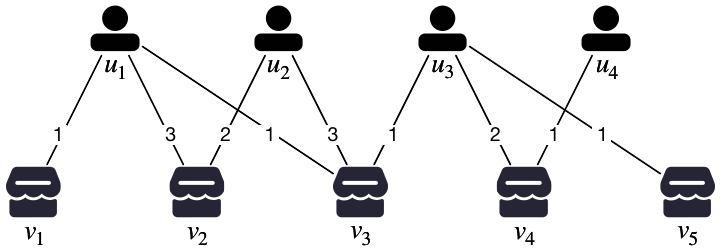
Figure 1. A weighted bipartite graph of the customer–product network (the weight on the edge denotes the number of times that the customer has bought the